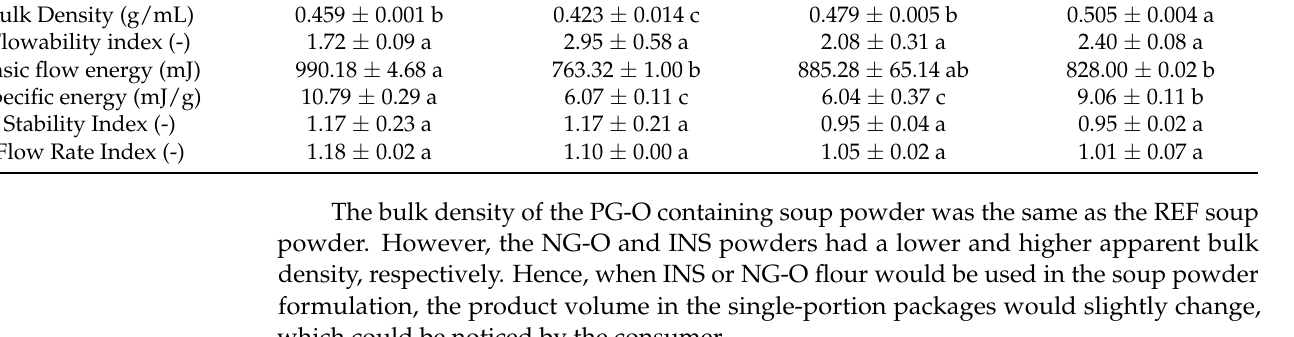
Table 2. Flow behaviour parameters for reference soup powder and soup powders containing non-gelatinised open cell chickpea flour (NG-O), pre-gelatinised open cell chickpea flour (PG-O), and commercial pre gelatinised open cell chickpea flour (INS). Values within one row indicated by the same letter are not significantly different ( α = 0.05). REF NG-O PG-O INS Bulk Density (g/mL) 0.459 ± 0.001 b 0.423 ± 0.014 c 0.505 ± 0.004 a Flowability index (-) Basic flow energy (mJ) Specific energy (mJ/g) Stability Index (-) Flow Rate Index